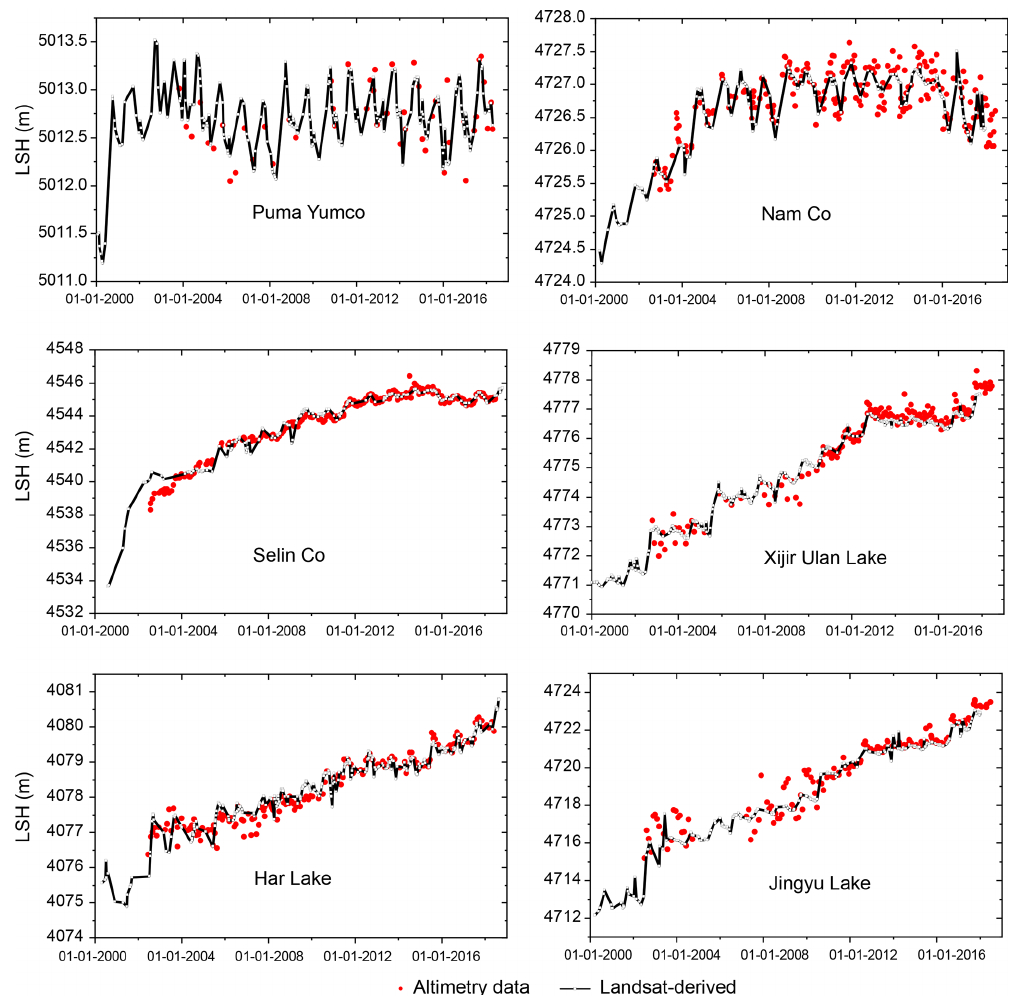
Figure 16. Lake water level (left y axis) estimates from our approach for six TP lakes. Black lines represent optical data and red dots represent altimetry data. LSH represents lake surface